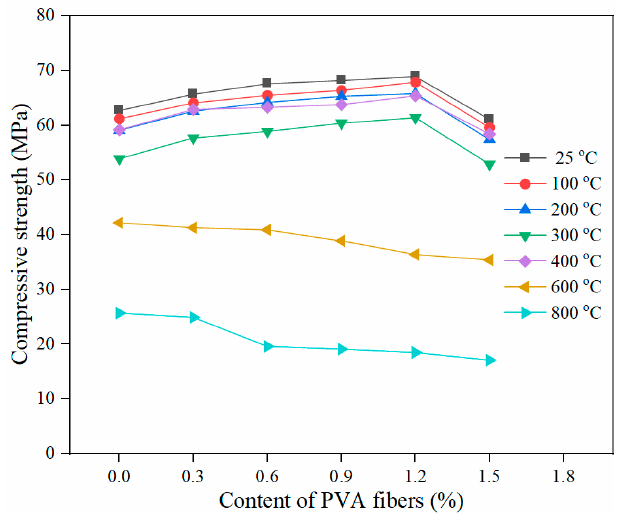
Figure 5. Compressive strength of PVA-FRCC samples after exposure to different temperatures.